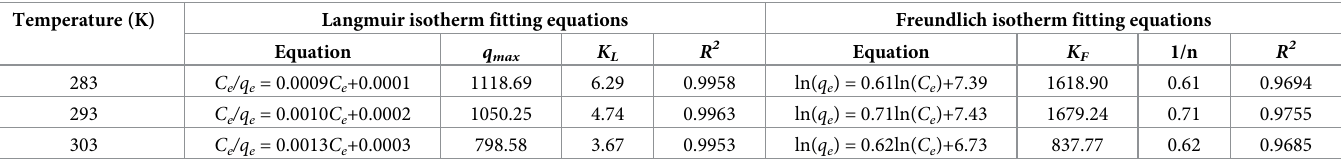
Fig 7 shows isotherms for AFB1 adsorption on MMS in oil. The adsorption isotherms had an upward convex shape, confirming that AFB1 could easily adsorb on MMS. The isotherms were fitted to different isothermal adsorption equations and the regression parameters for Langmuir and Freundlich models were calculated [33]. Table 6 shows that R 2 for fitting was greater for the Langmuir model than for the Freundlich model; all R 2 values for the Langmuir model were > 0.98. These results demonstrated that AFB1 adsorption on MMS in oil con- formed to the Langmuir model, with the assumption of monolayer AFB1 adsorption and uni- form distribution of adsorption sites on the MMS surface. The maximum amount of AFB1 Table 6. Langmuir and Freundlich isotherm fitting equations of AFB1 in oil. Temperature